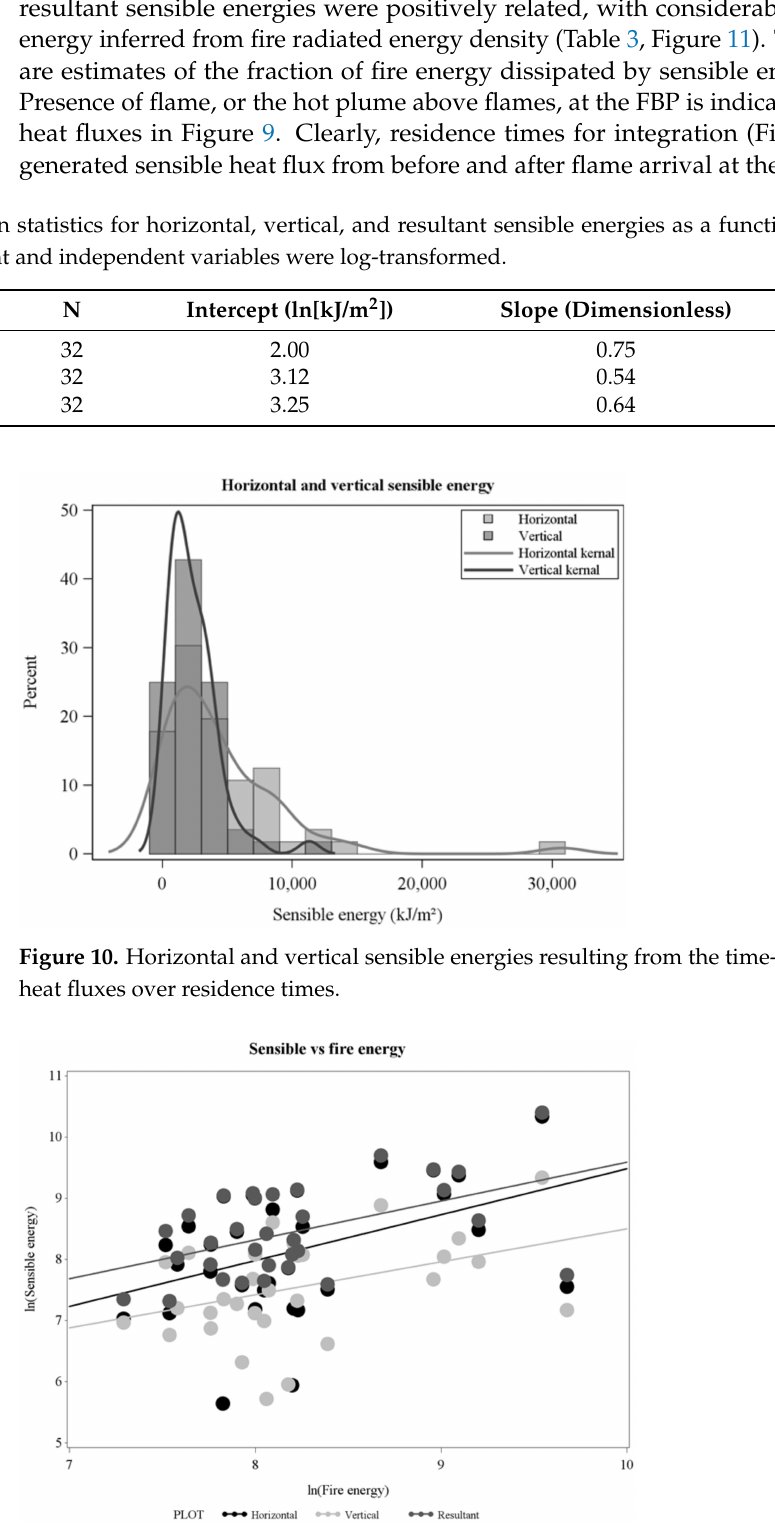
Figure 11. Horizontal, vertical, and resultant sensible energies (kJ/m 2 ) as a function of fire energy (kJ/m 2 ) estimated from overhead radiometers on natural log-transformed